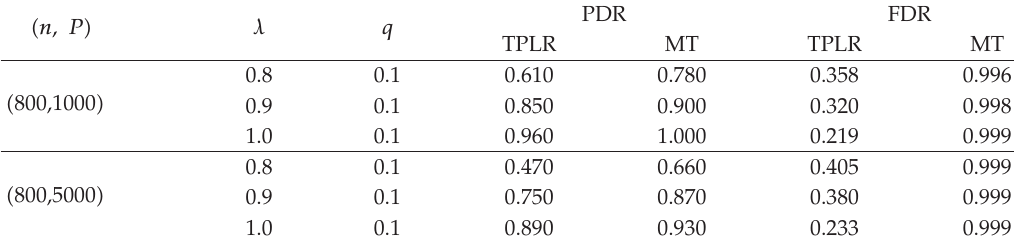
Table 2: The simulated average PDR and FDR under Model 1: multiplicative e ff ects both within and between loci.